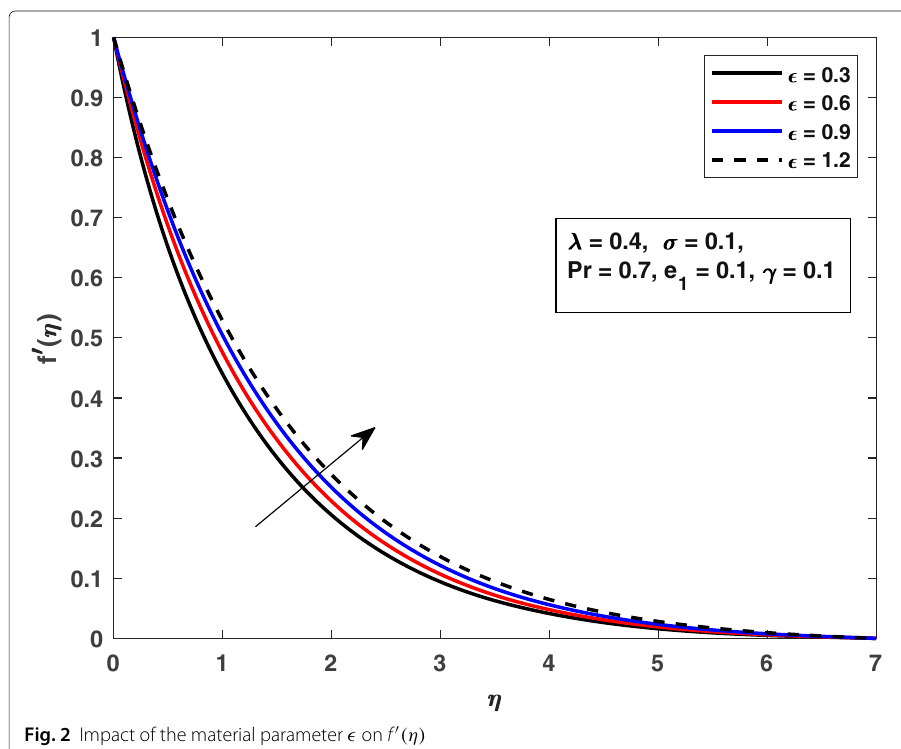
Fig. 2 Impact of the material parameter (cid:10) on f (cid:6) (η)